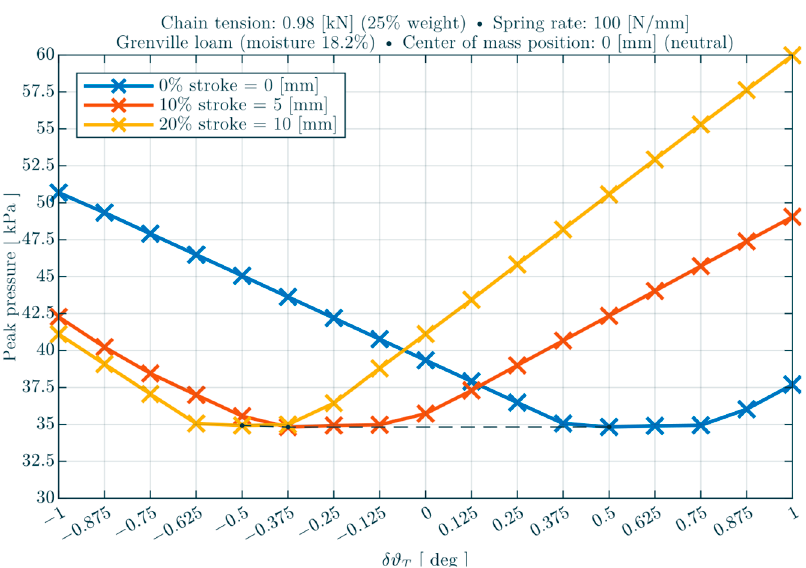
Figure 24. Peak pressure beneath the track module as a function of δϑ T : spring preload effect.